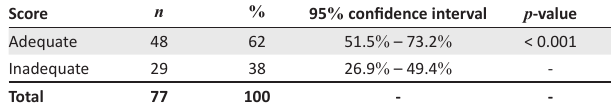
TABLE 1: Score of adequacy of diagnostic ultrasound reports.